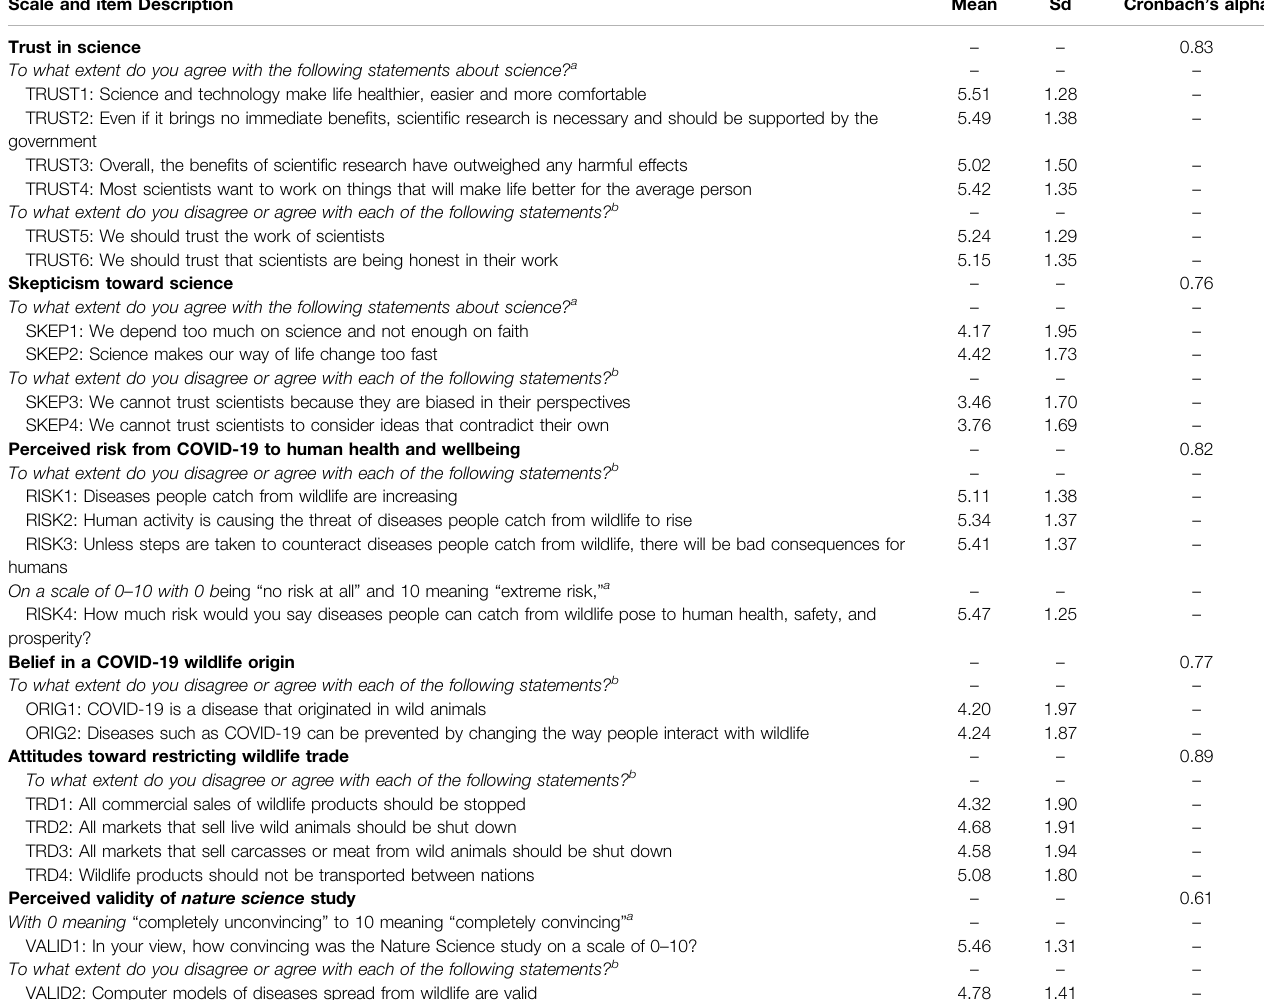
TABLE 1 | Means, standard deviations, and Cronbach ’ s Alpha for scale items ( n (cid:1) 1,554). Scale and item